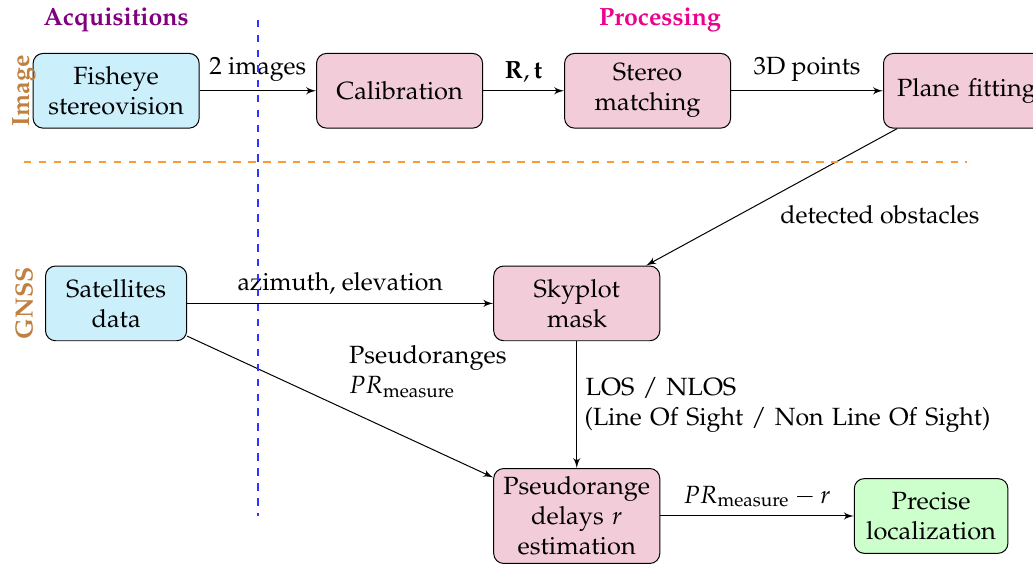
Figure 2. Procedure scheme for the 3D modelling and integration with GNSS (Global Navigation Satellite System) data. R , t = rotation and translation between